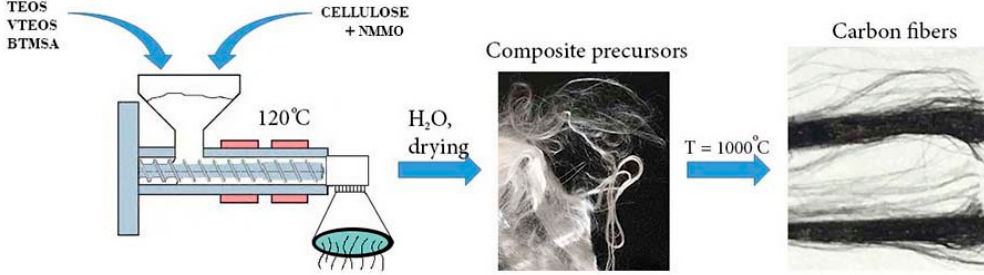
Figure 1. Basic stages of cellulose composite precursors and carbon fibers production. TEOS, Tetraethoxysilane; VTEOS, Vinyltriethoxysilane; BTMSA, Bistrimethylsilyl acetylene; NMMO, N-methylmorpholine-N-oxide.